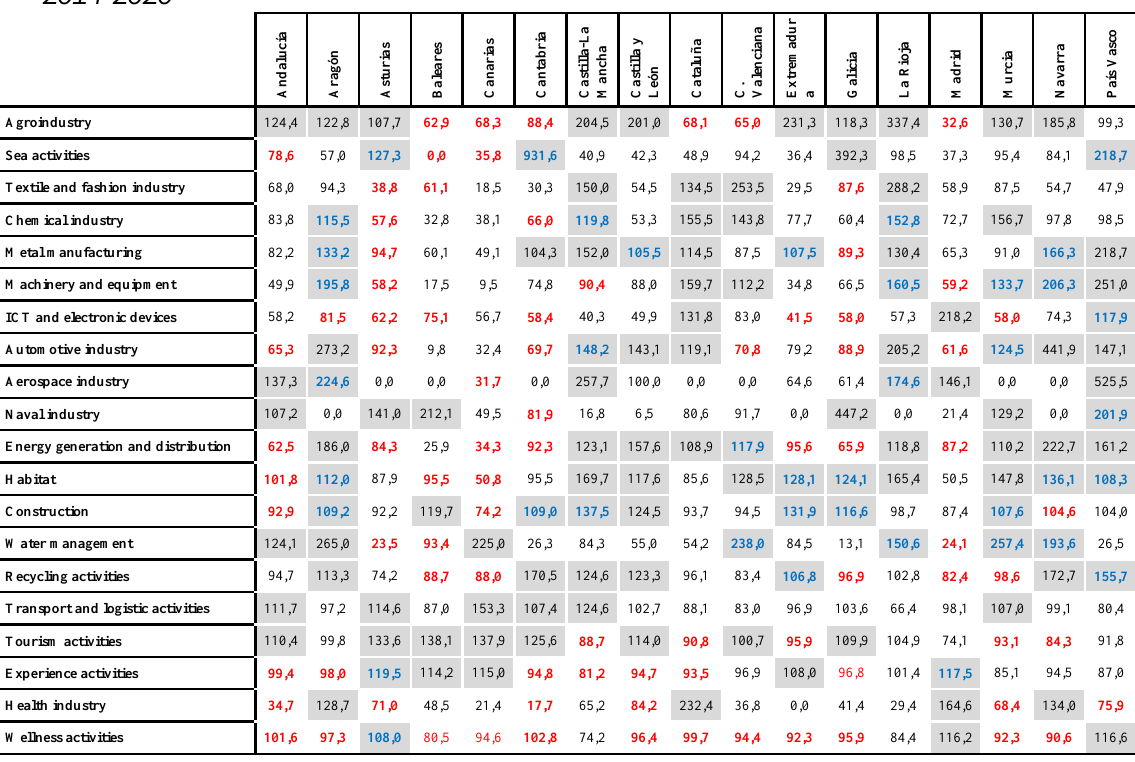
Table 4: Regions in Spain by Type of Economic Priority Included in the